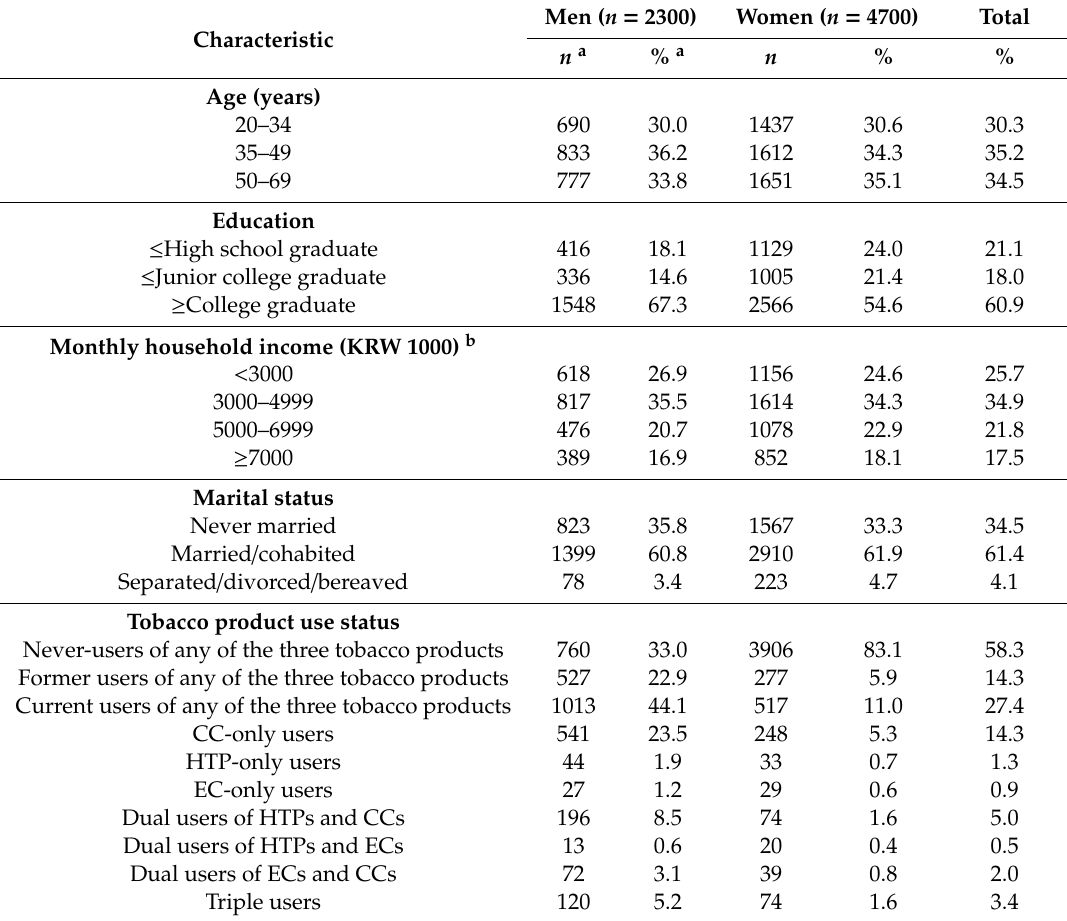
Table 1. Basic characteristics of the study participants ( n =